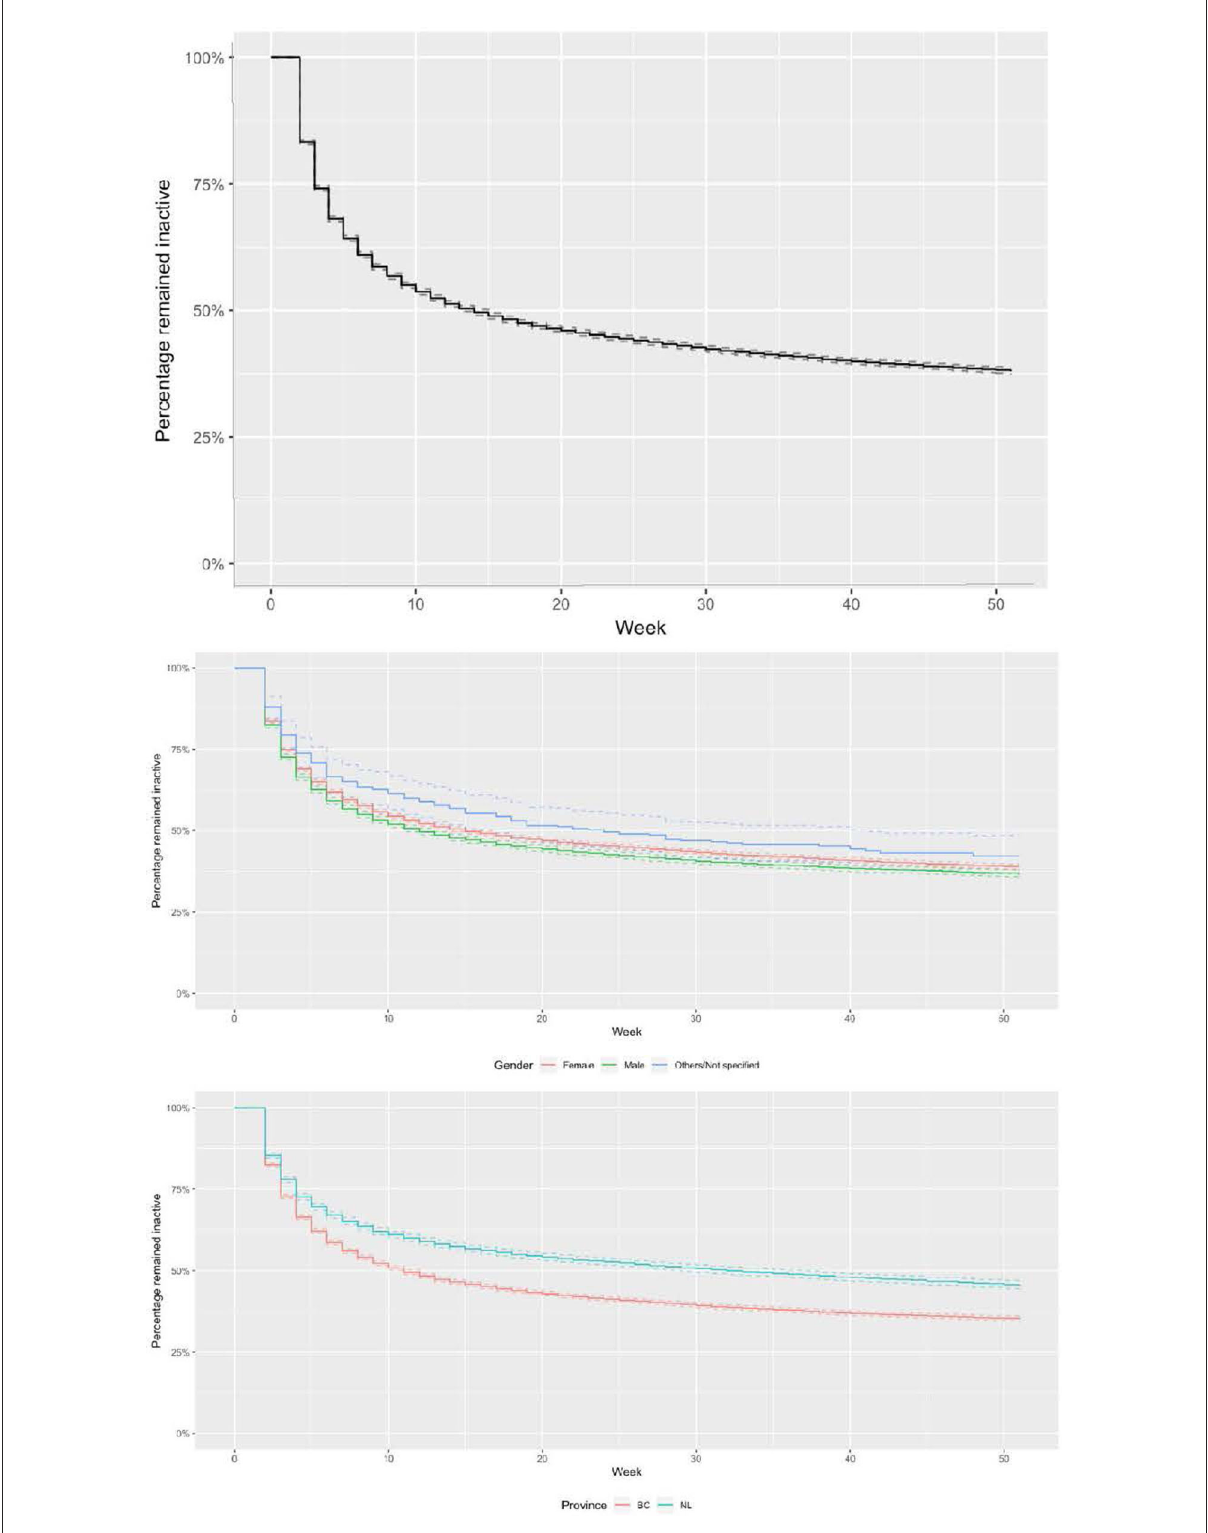
FIGURE3 Kaplan-Meier estimates of the survival distribution for time to resume a second streak for the total sample (top) by gender (middle) , and by province (bottom)